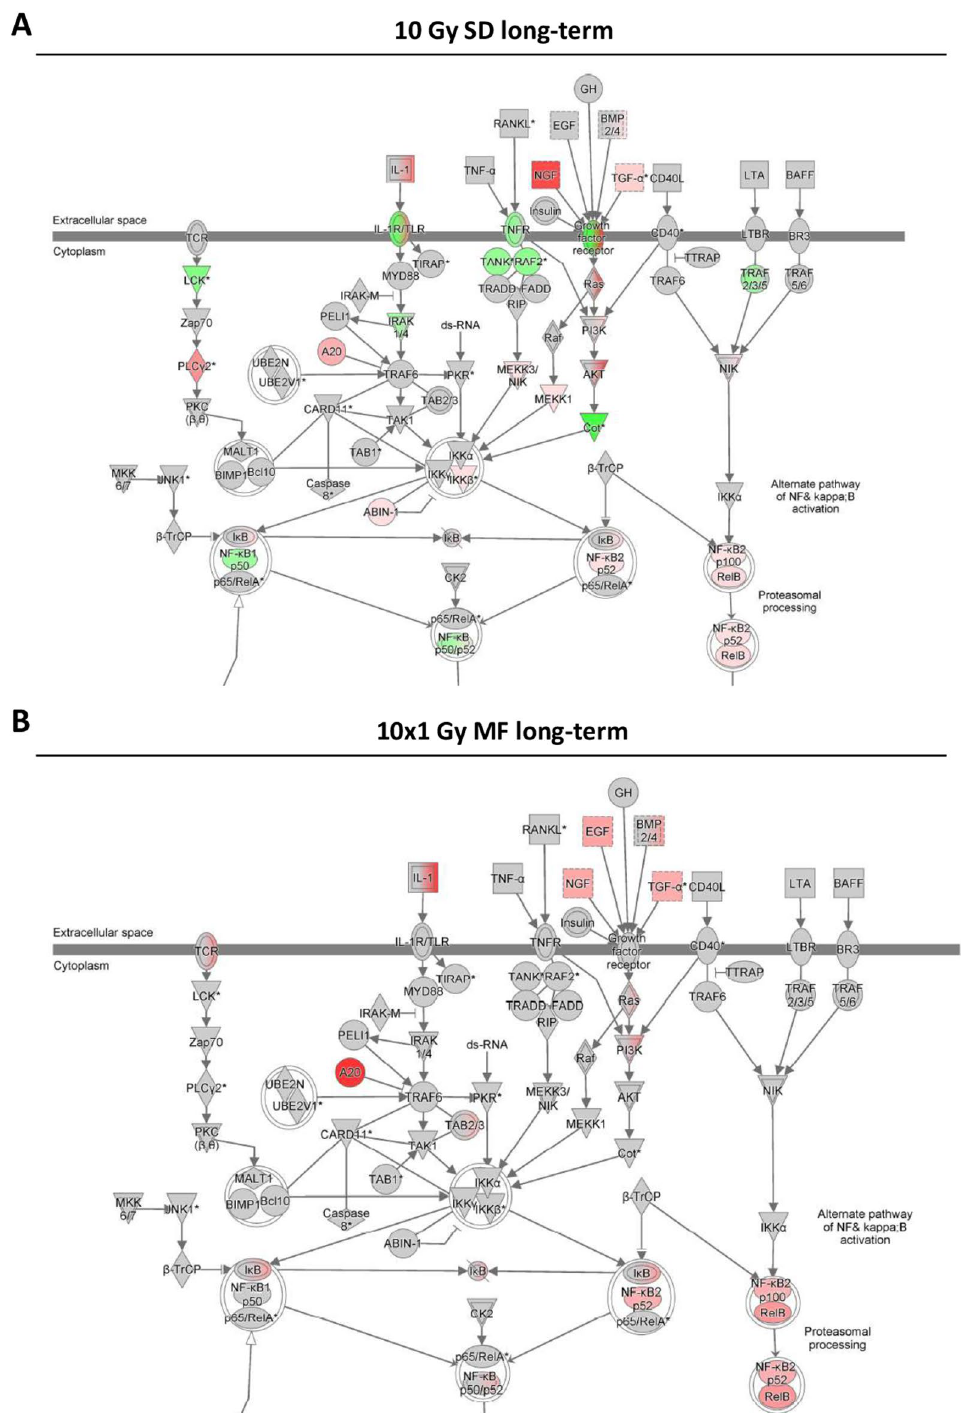
Figure 4. Single-dose and multifractionated irradiation activate pathways in a different manner. Gene expression in PC3 cells ( A ) at 2 months (long-term) after a single-dose (SD) irradiation of 10 Gy or ( B ) at 24 h (short-term) after a multifractionated (MF) irradiation of 10 times 1 Gy was analyzed with Ingenuity Pathway Analysis (IPA) software from Qiagen. Red color indicates upregulation, green color indicates downregulation, and white color indicates no change. Arrows and lines between molecules indicate associations and